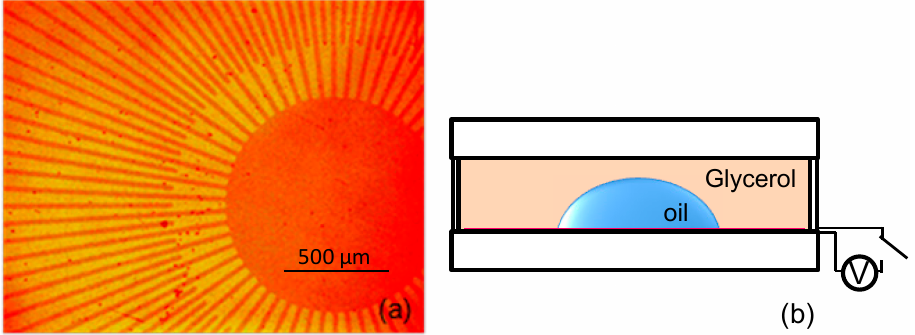
Figure 2. ( a ) Image of partial ITO pattern and ( b ) side-view structure of the lens cell.